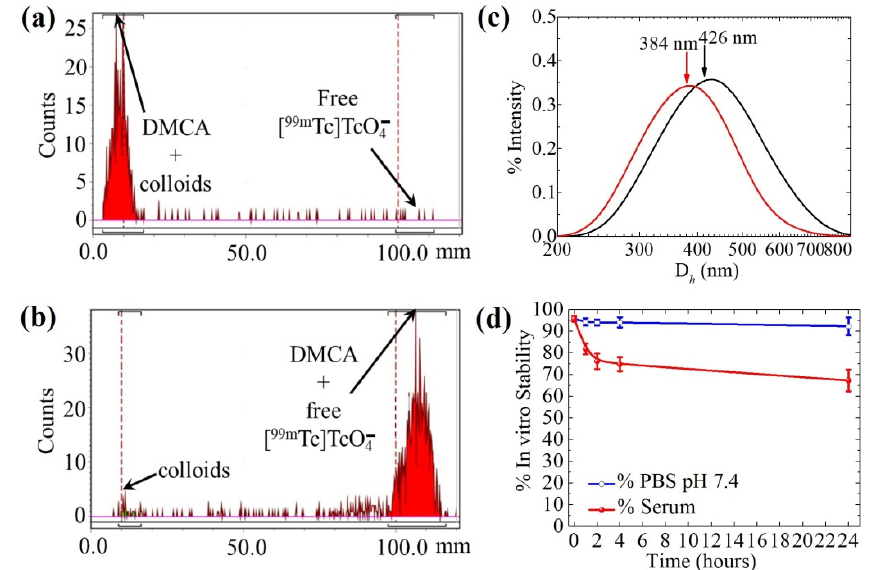
Figure 1. Radio-chromatograms of [ 99m Tc]Tc-DPD-Fe 3 O 4 DMCA applied on ITLC-SG strips and developed with ( a ) acetone and ( b ) sodium citrate solution (0.1 M); ( c ) hydrodynamic diameter (D h ) of [ 99m Tc]Tc-DPD-Fe 3 O 4 DMCA, as determined by DLS. Two independent measurements are illustrated; ( d ) in vitro stability of [ 99m Tc]Tc-DPD-Fe 3 O 4 DMCA incubated in PBS (pH 7.4) on a shaker at RT and in human serum at T = 37 °C, as both determined by ITLC-SG chromatographic analysis at 1, 2, 4 and 24 h of incubation. The percentage (%) of in vitro stability corresponds to the overall mean value ± standard deviation (MV ± SD) of three independent experiments.